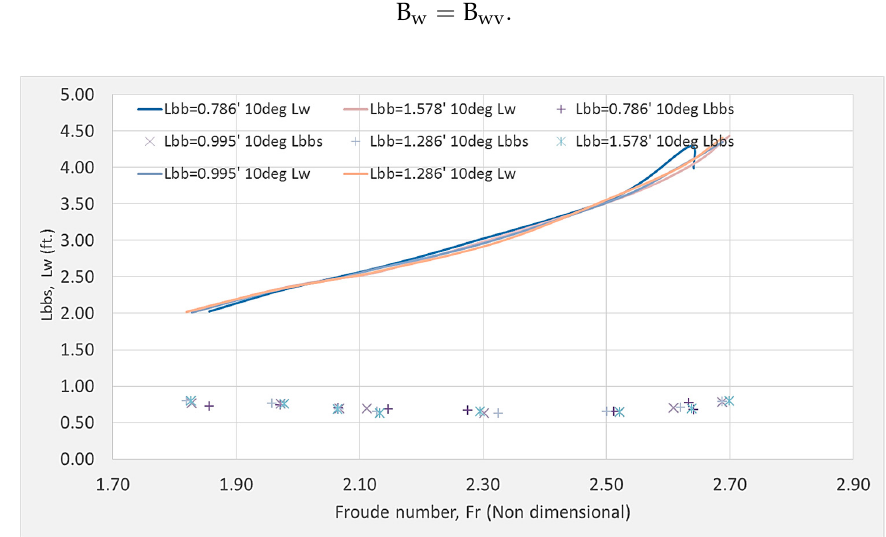
Figure 19. L bbs and L w , at 5° pitch angle.